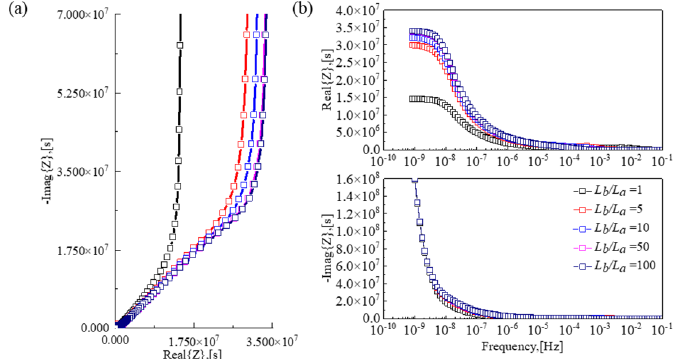
Figure 5. Impedance spectroscopy of different width-to-thickness ratios (Bi = 100). ( a ) Nyquist figure, ( b ) variation curve of real part and imaginary part with frequency.